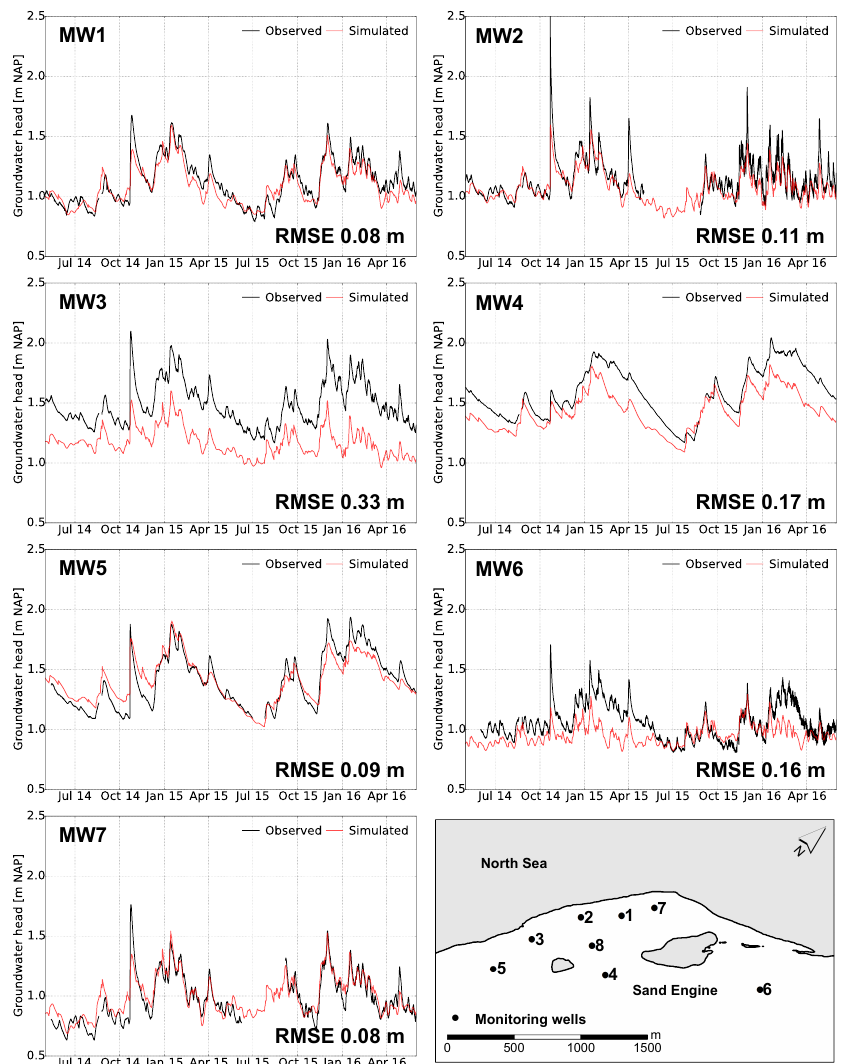
Figure 6. Observed and simulated groundwater level in MW 1–7 (phreatic aquifer 1: see Fig. 2), from May 2014 to June 2016.